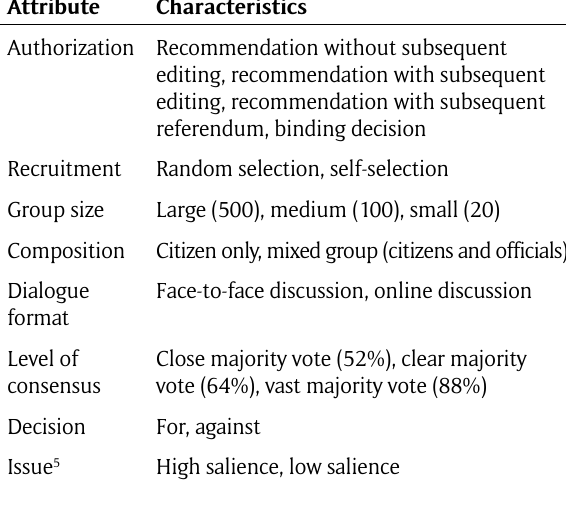
Table 1: Design features of deliberative forums.